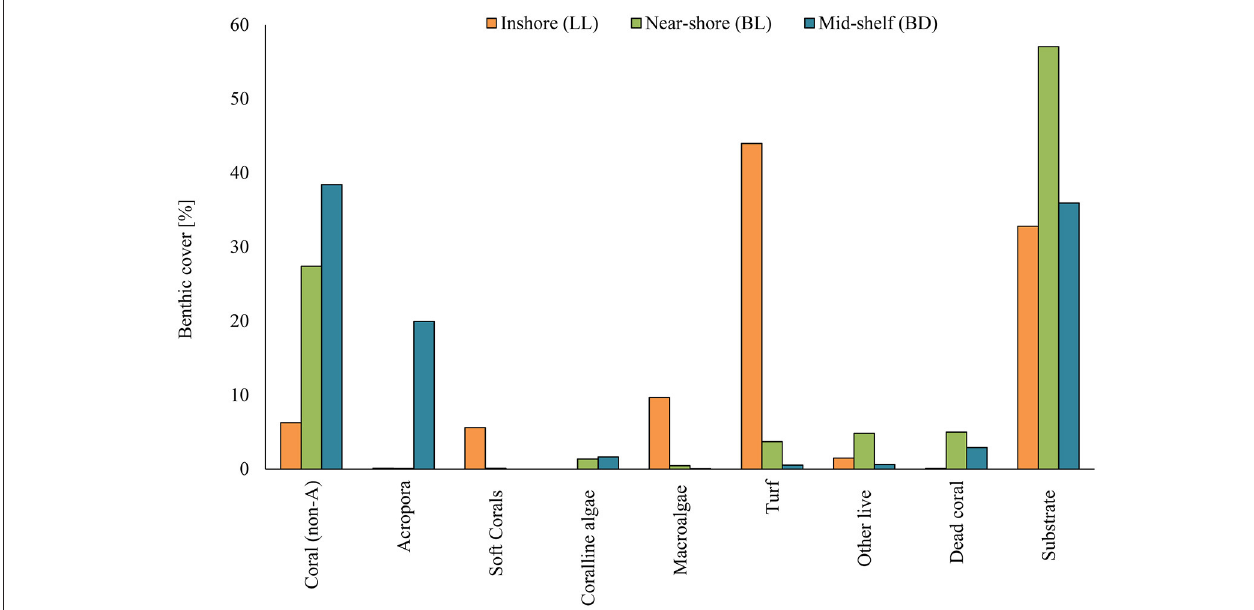
FIGURE 2 | Benthic community composition at the three sites: inshore (LL), near-shore (BL), and mid-shelf (BD). Live categories include Coral (non-Acropora hard corals), Acropora, soft corals, crustose coralline algae, turf algae, and others. Dead coral and bare substrates (sand, rock, rubble) complete the cover as non-living